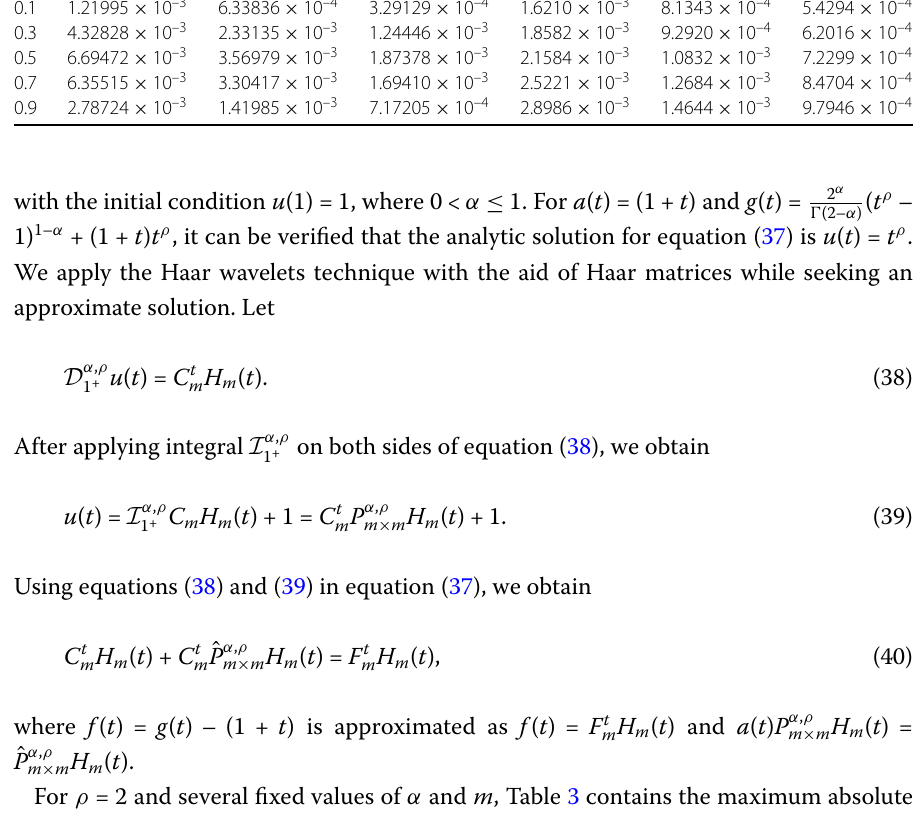
Table 3 Maximum absolute error for ρ = 2 and for different values of m , α α Haar wavelets Discretization [40] m =